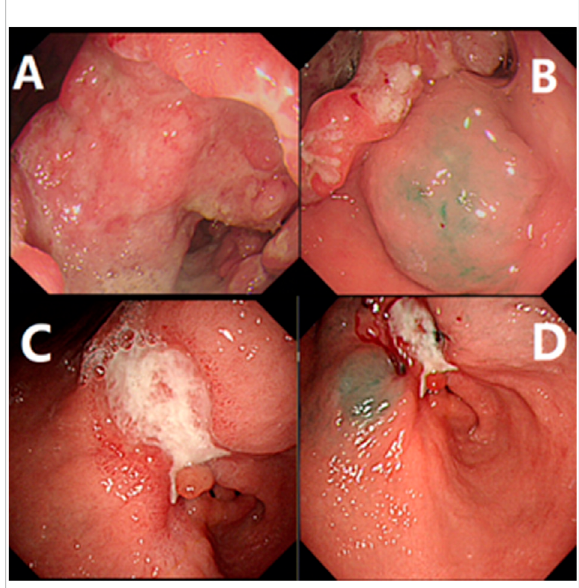
FIGURE 1 Gastroscopy examination and indocyanine green injection. (A) showed the result of electronic gastroscopy before treatment, showing an ulcerous lesion in the gastric antrum, about 6*7 cm in size, gastric cancer (Borrmann III type), (B) showed indocyanine green was injected submucosally at the edge of the lesion before treatment; (C) showed the result of electronic gastroscopyafterneoadjuvanttreatment,thesizeisabout3*2 cm, gastric cancer (Borrmann type II), the lesion is smaller than the previous. (D) showed indocyanine green is injected as before after neoadjuvant